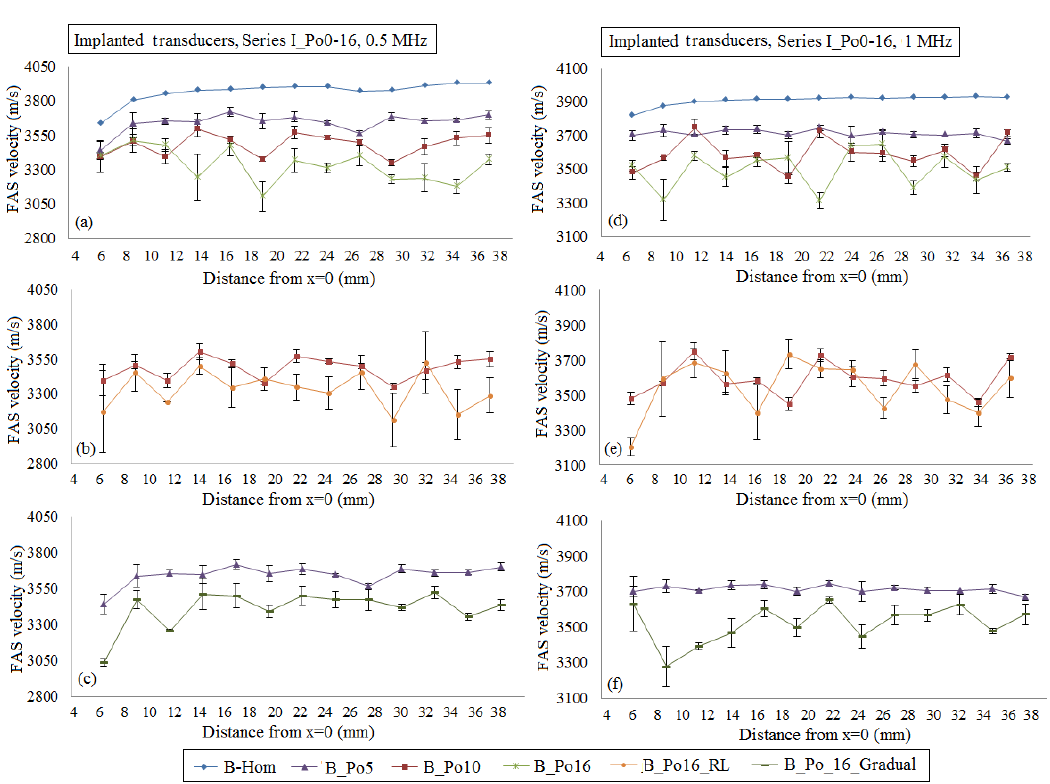
Figure 4d. For the excitation frequency 1 MHz, the relative percentage differences for the cases B_Po5, B_Po10 and B_Po16 were from 3.14% to 6.67%, 3.91%–12.10% and 7.35%–15.56%,